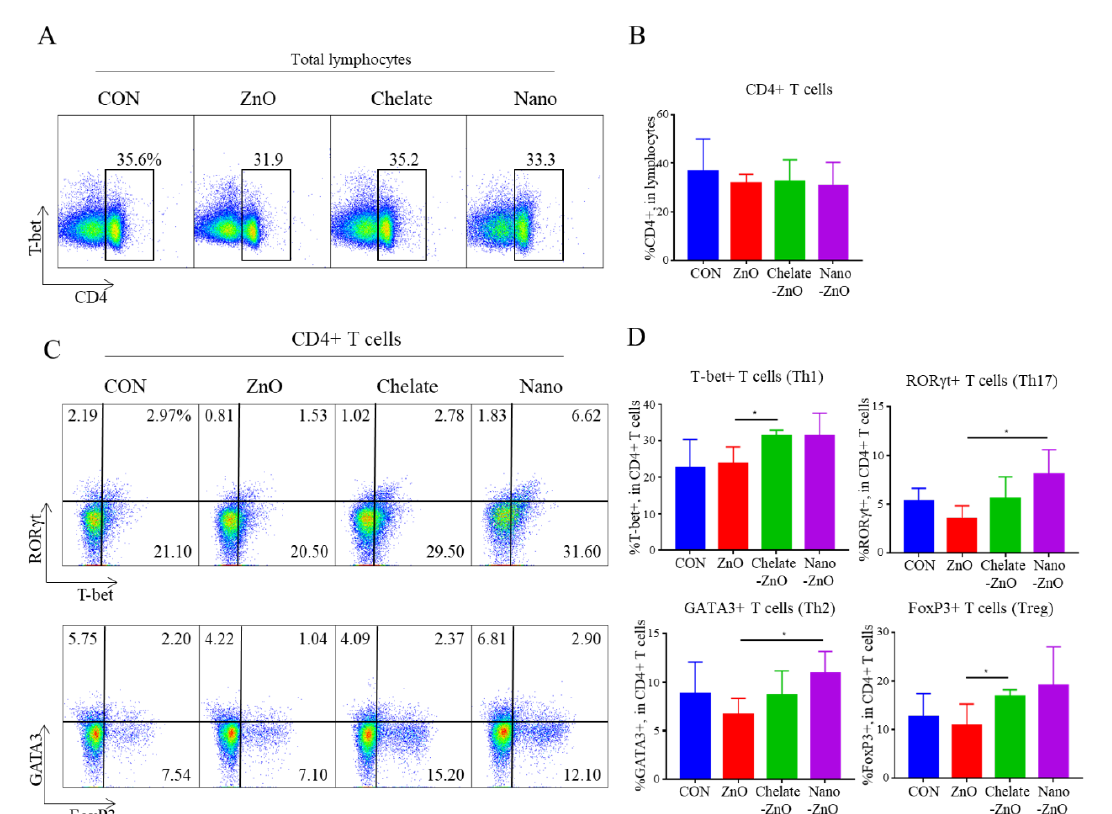
Figure 4. Population of CD4+ T cell subsets in mesenteric lymph node (MLN) of weaned piglets fed alternative form of zinc oxide. Forward scatter and side scatter were used to identify lymphocytes among live cells. Figures represent dot plots and graphs of CD4+ T cell ( A , B ) and its subsets ( C , D ) in piglets fed different forms of zinc oxide. CD4+ T cell subsets were identified by using the transcription factors T-bet, GATA3, ROR γ t, and FoxP3; T-bet, ROR γ t, and FoxP3 were gated simultaneously. Data are represented as mean ± SD. Values were statistically analyzed by unpaired t -test. * p < 0.05.